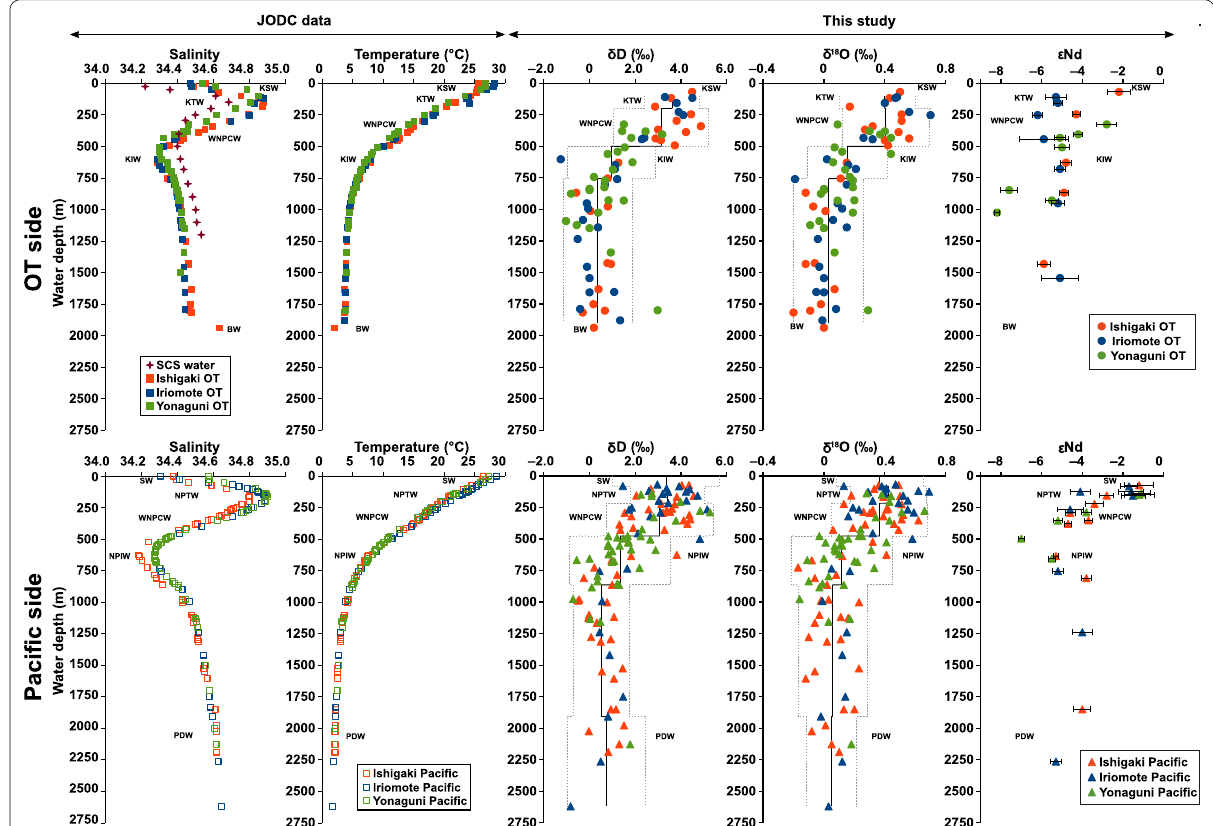
Fig. 3 Depth profiles of salinity, temperature, and hydrogen (δD), oxygen (δ 18 O) and neodymium (εNd) isotope compositions for the Okinawa Trough (upper panels) and Pacific (lower panels) sides of the southern Ryukyu Island Arc. The salinity and temperature profiles are based on the data collected from 1 January 1990 to 31 December 2019 (Japan Oceanographic Data Center 2021). Wine-colored symbols in the salinity profile of the Okinawa Trough side indicate salinity measured in the South China Sea water (Japan Oceanographic Data Center 2021). Solid lines in the δD and δ 18 O profiles indicate mean δD and δ 18 O values in individual water masses. Dotted lines indicate mean 2σ ranges. Horizontal bars in the Nd ± isotope profiles represent analytical errors (2SD). Okinawa Trough side (upper panels): KSW, Kuroshio Surface Water; KTW, Kuroshio Tropical Water;